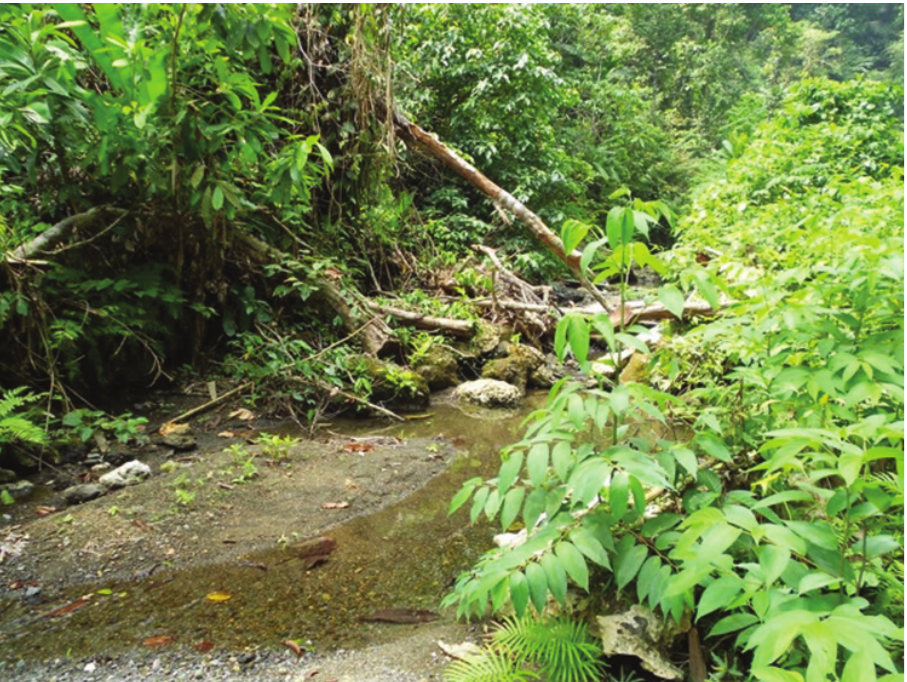
Figure 1. Wano Land, Mokndoma, small forest stream; photo by M. Wild.